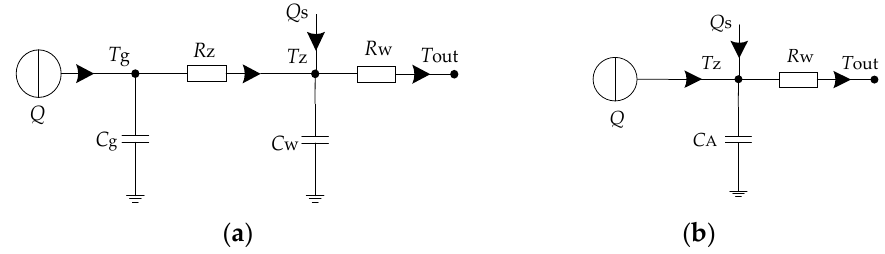
Figure 2. ETP models for different heating/cooling systems. ( a ) RFHCS; and ( b ) CHCS.